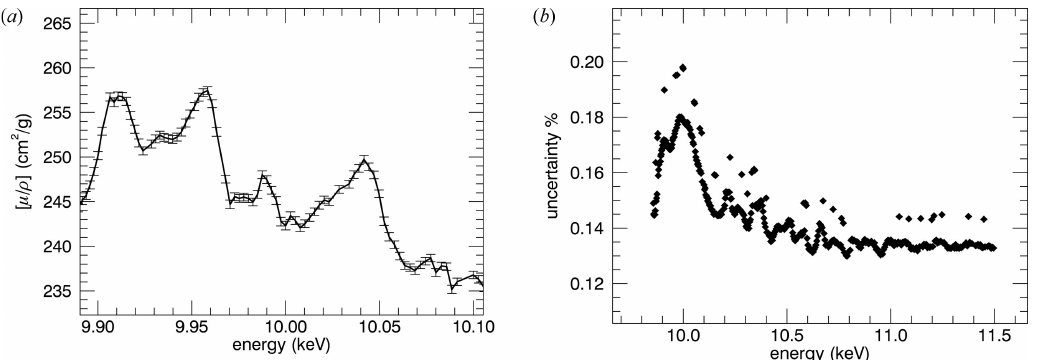
Figure 21 ( a ) A sample of the spectra with uncertainties from the 10 K, 50 m m fluorescence spectra. ( b ) The percentage uncertainty in the fluorescence spectra of 10 K, 50 m